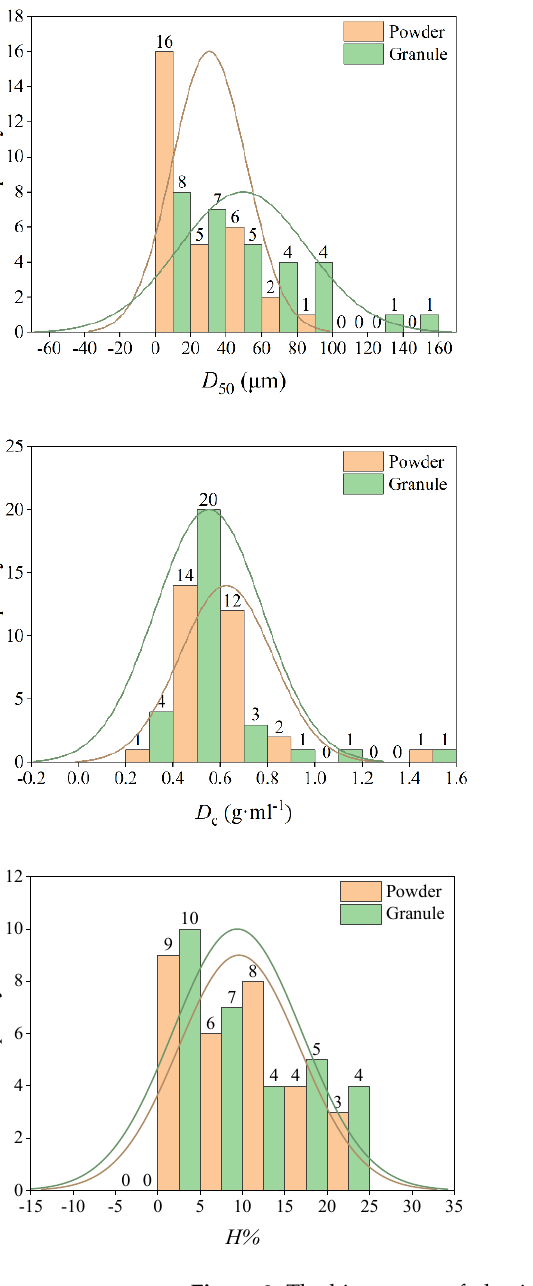
Figure 2. The histograms of physical properties for powders and granules. ( a ) the median diameter D 50 . ( b ) the bulk density D a . ( c ) the tapped density D c . ( d ) the angle of repose AOR . ( e ) the hygroscopicity %H . ( f ) the cohesion index Icd